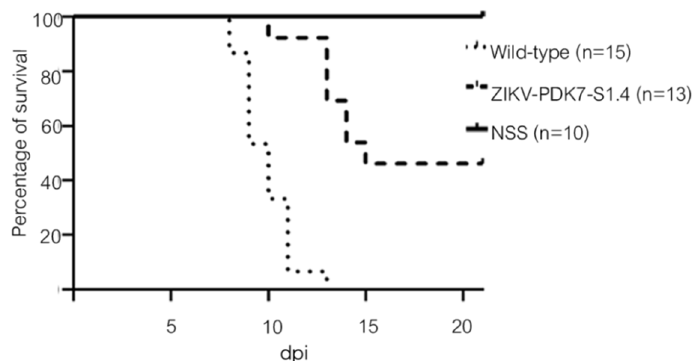
Figure 8. Mouse neurovirulence. Two-day-old ICR mice were intracranially injected with 2 × 10 4 pfu of the wild-type ZIKV (dotted line), ZIKV-PDK7-S1.4 (dash line), or NSS (solid line). The mice were observed daily for morbidity and mortality for 21 days. The survival rate analyzed by Log-rank (Mantel–Cox) tests shows significant differences between the mice infected with the ZIKV-PDK7-S1.4 isolate and the wild-type ZIKV infection ( p < 0.0001).